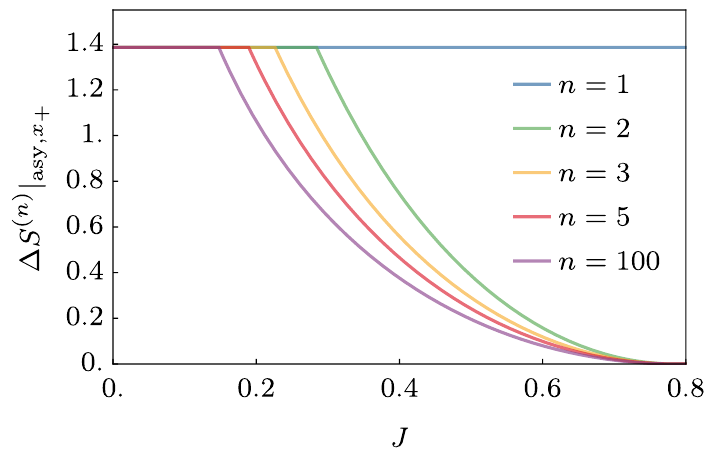
Figure 2: The asymptotic slope ∆ S ( n ) | (82) as a function of the gate parameter J asy, x + (see Appendix C for details on the parametrisation) for different values of n (different colors). The slope is n -independent in the maximal-growth region but both the size of this region and the slope away from it depend on n .